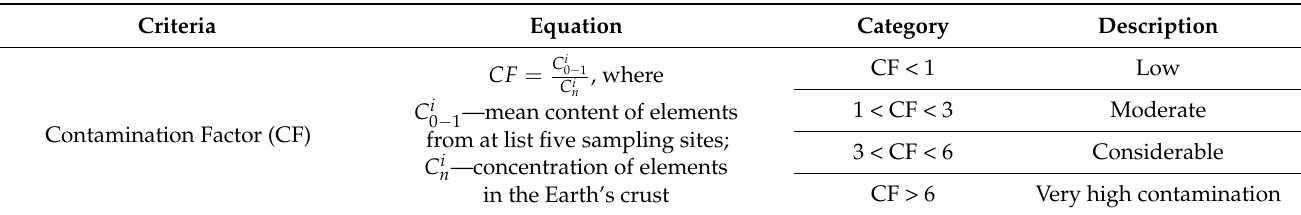
Table 2. Single- and multi-element criteria of contamination level and potential ecological risk in bottom sediments